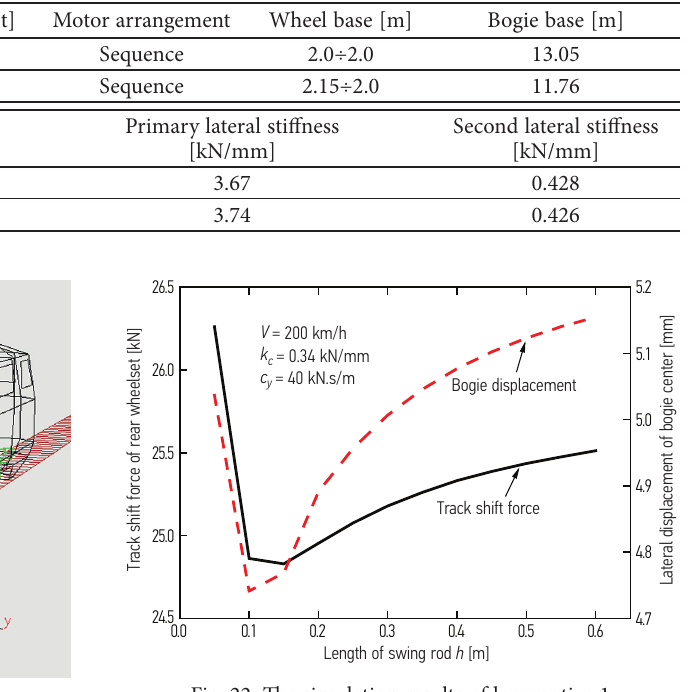
Fig. 20. The multiple-body-dynamics model of locomotive